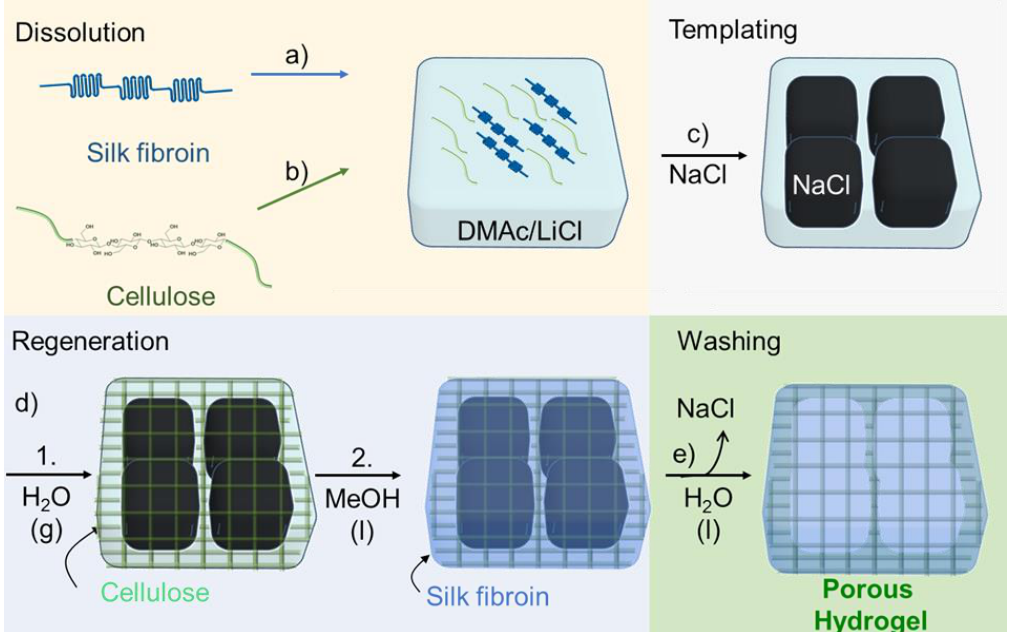
Figure 1. Hydrogel preparation. Dissolution: (a) Dissolving silk fibroin (SF) in DMAc/LiCl. (b) Dissolving cellulose in the SF solution. (c) Templating: Addition of NaCl powder. (d) Regeneration: 1. Cellulose is regenerated by water entering from air, gelation occurs; 2. soaking in methanol, SF is insolubilized. (e) Washing: Removal of porogen and solvent, a porous hydrogel is formed.